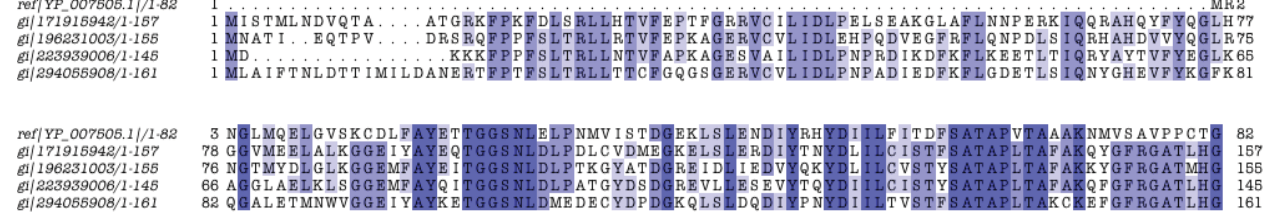
Figure 5. Alignment of a unique leucyl aminopeptidase family. The domain was discovered following five iterations with PSI-BLAST with pc0506 as query sequence (YP_007505.1). Display conventions as in Figure